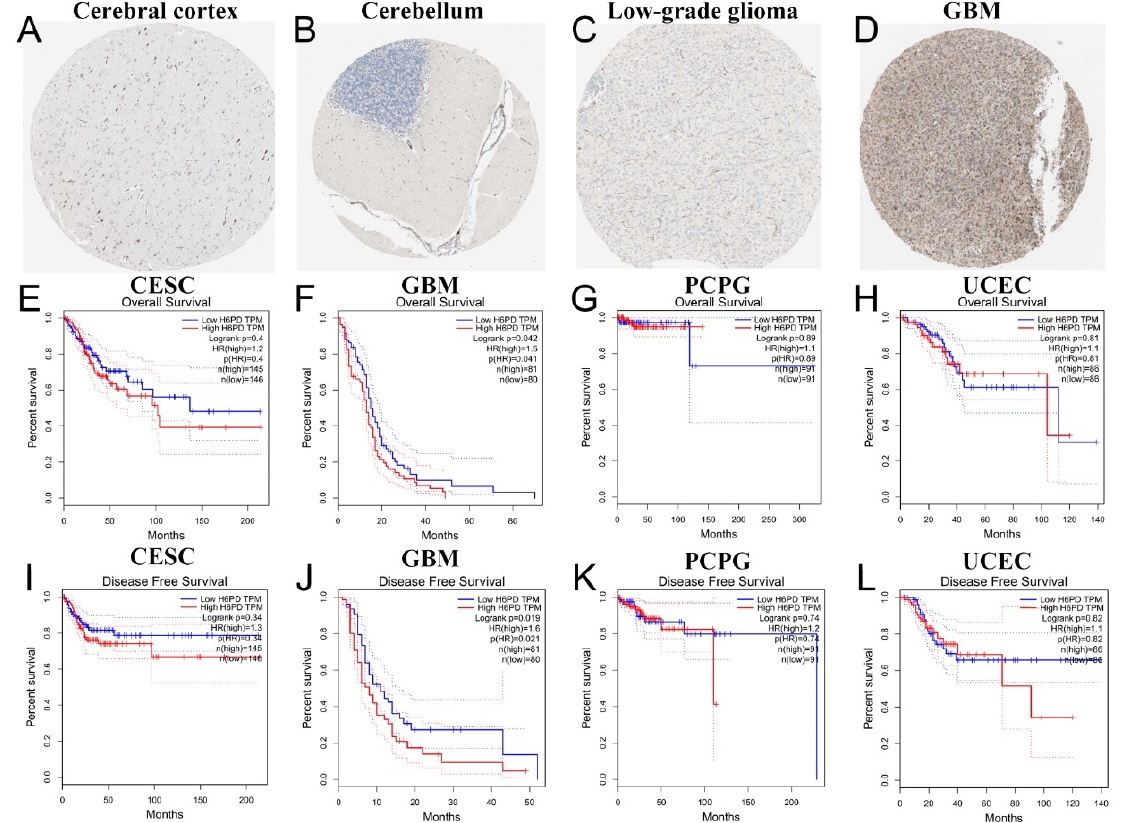
Figure 2. Immunohistochemistry and survival analysis of H6PD. ( A – D ) Low expression of H6PD was detected in the cerebral cortex, cerebellum, and low-grade glioma. Abundant H6PD expression was detected in GBM. ( E – L ) OS and DFS of CESC, GBM, PCPG, and UCEC are shown. For overall survival (OS) and disease-free survival (DFS), high expression of H6PD was significantly associated with poor prognosis in GBM patients. H6PD was not statistically significant in predicting the prognoses of patients with other cancer